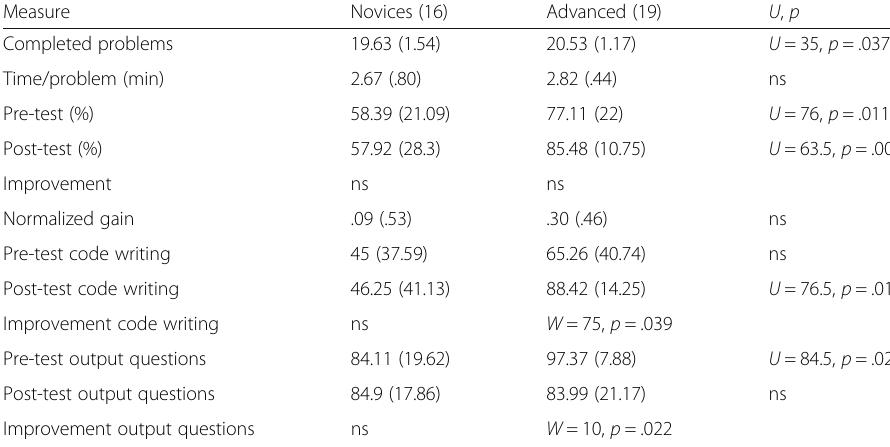
Table 4 Novices vs. advanced students ( ns denotes not significant)